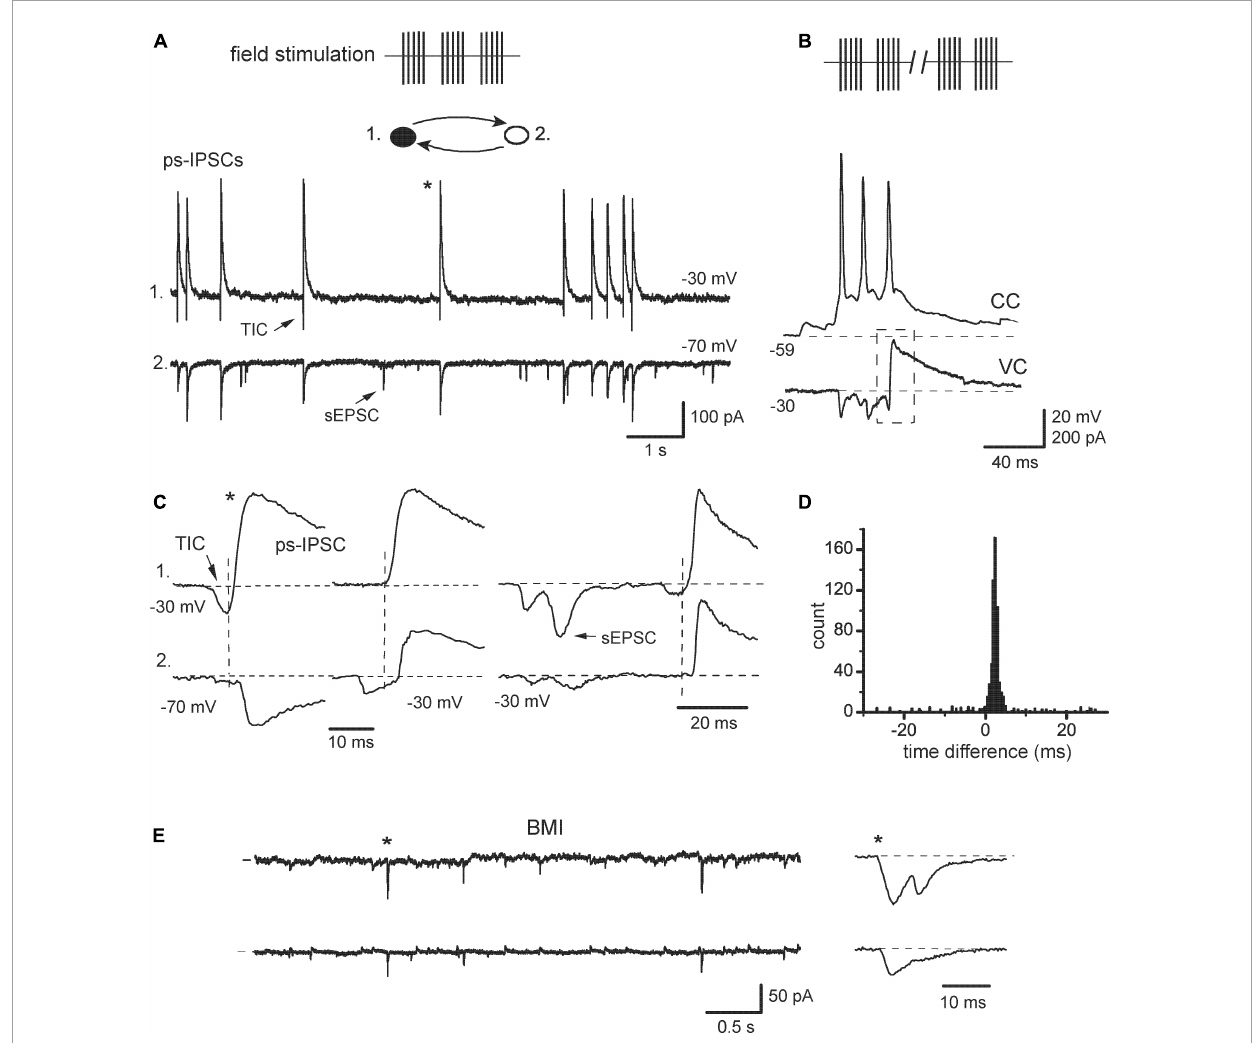
FIGURE3 Transformation of sIPSCs after network activation. (A) “Hypersynchronous” sIPSCs observed after field electrical stimulation ( ps-IPSCs ), they were preceded by transient inward currents ( TIC ). Inset : filled circles, IN; open, EN. Random sEPSC is marked by an arrow [ (A,C–E) , same recording]. (B) An example of epileptiform bursting episodes induced after prolonged stimulation. One cell in a pair was in current-clamp mode ( CC ) to show action potentials. The other cell was kept in a voltage-clamp (VC), which revealed an excitatory-inhibitory sequence ( dashed box ) as an intrinsic component of the bursting episode. (C) Different examples of sequences TIC/ps-IPSC are expanded to show the timing of the events ( vertical lines ), and asterisk shows the events taken from the segment in panel (A) . Cell #1 was constantly held at –30 mV, while cell #2 was held first at –70 and then at –30 mV. (D) Time difference histogram. (E) Application of bicuculline (BMI) blocked outward Cl − currents and revealed synchronous excitatory currents; one of them is expanded to the right